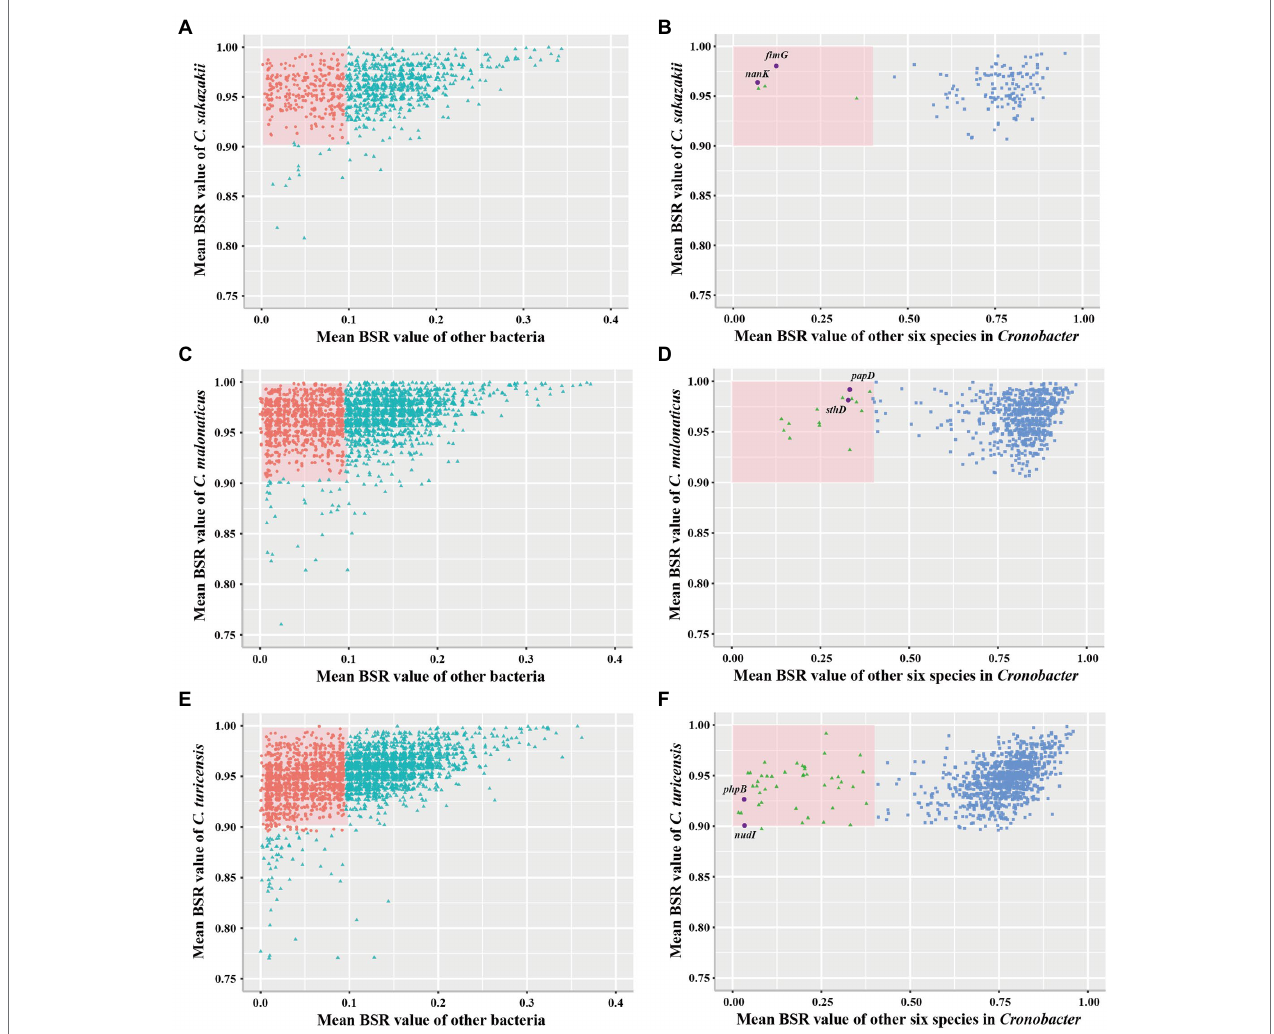
FIGURE 3 | Conserved single-copy core genes of Cronobacter sakazakii , Cronobacter malonaticus , and C. turicensis were further evaluated by LS-BSR. (A,C,E) LS-BSR analysis of each conserved genes among target species and non- Cronobacter bacteria. (B,D,F) LS-BSR analysis of each gene analyzed again among target species and other six species of Cronobacter